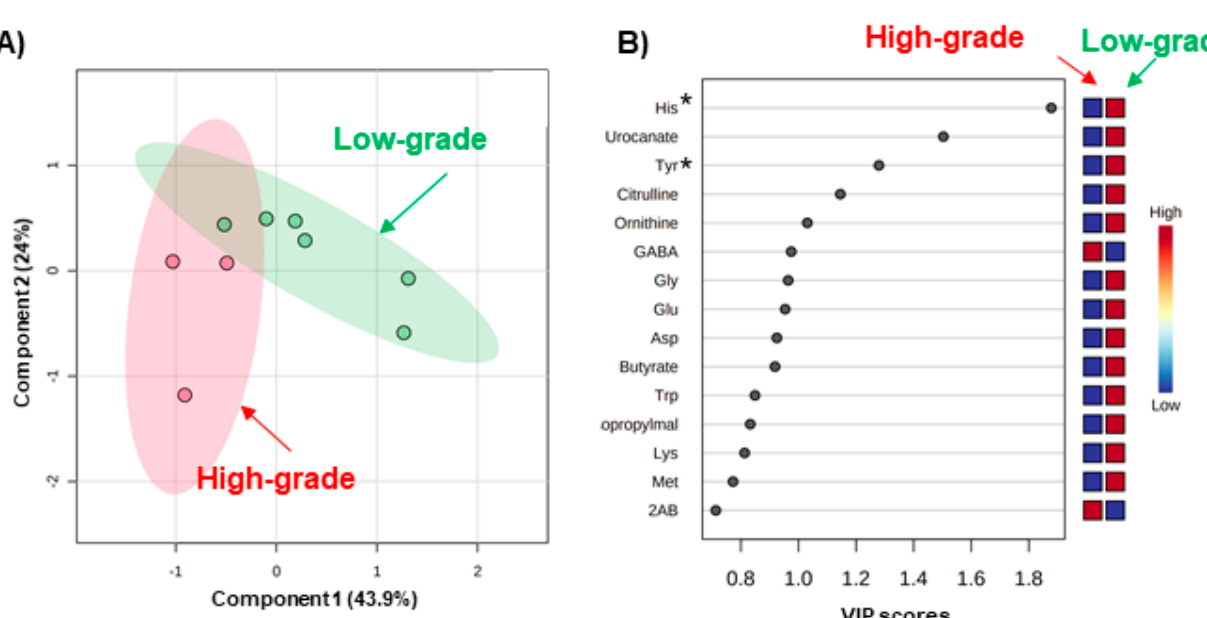
Figure 2. PLS-DA of metabolite concentrations in the saliva samples collected before radiation therapy. ( A ) Score plots. The predictive capabilities are R 2 = 0.93 and Q 2 = 0.40 by 9-fold-cross validation. The pink and green plots indicate the patients with high- and low-grade oral mucositis. The plots with short distances indicate a high similarity pattern of salivary metabolite concentrations, and, oppositely, the plots with large distances indicate large different patterns. The filled circles colored light pink and light green indicate the 95% confidence intervals of each group. For these analyses, the absolute metabolite concentration was normalized using scale range. X and Y axes are the 1st and 2nd components, e.g., the most and second most important components to explain the high- and low-grade groups. Their cumulative contribution rates are 43.9% and 24%, respectively ( B ) VIP score. Each plot indicates the VIP score of the metabolites used in this analysis. The higher VIP score indicates a higher contribution to discriminate the high-grade and low-grade groups. * is added to the metabolites with p < 0.05 (Mann–Whitney test). Boxes on the right indicate a heatmap. Red and blue indicated higher and lower concentrations. For example, regarding histidine (His), the averaged concentrations were lower in the high-grade groups compared to those in low-grade groups.